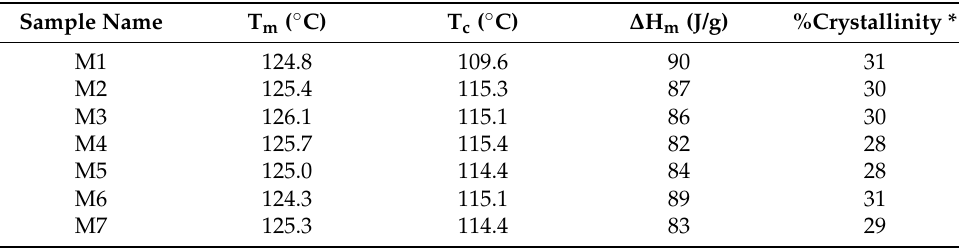
Figure 6. The DSC cooling thermograms for the nanocomposite sheets M1 – M7 measured with heating rate of 10 °C/ min from 25 °C to 220 °C under nitrogen atmosphere. Table 3. Summary of the DSC results of the prepared HDPE/CNTs nanocomposite sheets under nitrogen atmosphere, at a heating rate of 10 °C /min. 25 °C to 220 °C.